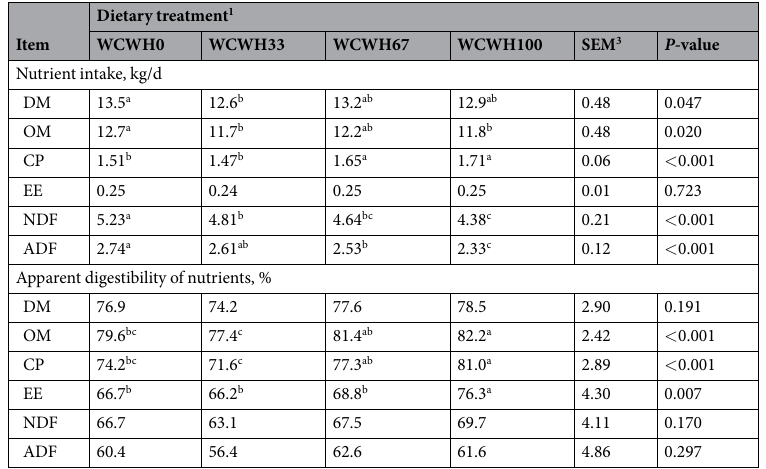
Table 1. The effects of treatments on feed intake and apparent digestibility of Holstein dairy bulls during the fattening period 1,2 . 1 WCWH0 = 0% of Leymus chinensis was replaced by whole-crop wheat hay; WCWH33 = 33% of Leymus chinensis was replaced by whole-crop wheat hay; WCWH67 = 67% of Leymus chinensis was replaced by whole-crop wheat hay; WCWH100 = 100% of Leymus chinensis was replaced by whole-crop wheat hay. 2 a–c: Means within the same row without the same letter superscripts are significantly different (Tukey’s test; P < 0.05). 3 SEM: Standard error of the